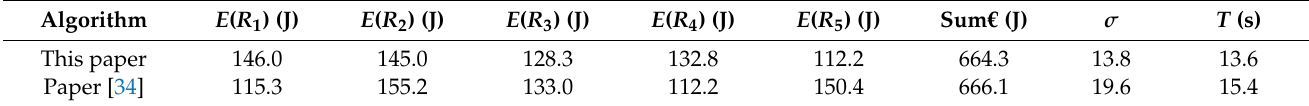
Table 3. Comparison of algorithm parameters from Experiment 3.